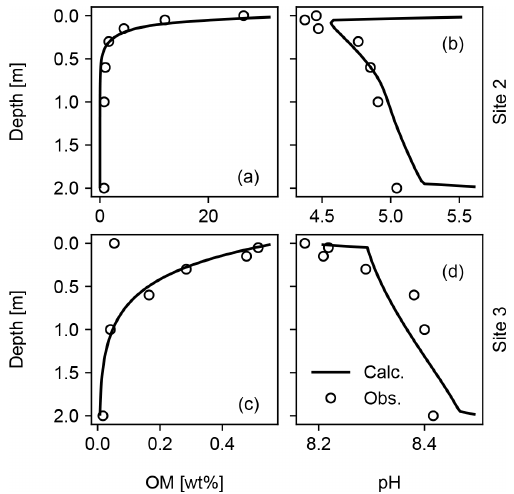
Figure 13. Model fit to observed depth profiles of soil OM and pH for Sites 2 and 3 in Table 8. See Sect. 3.2.1 for the